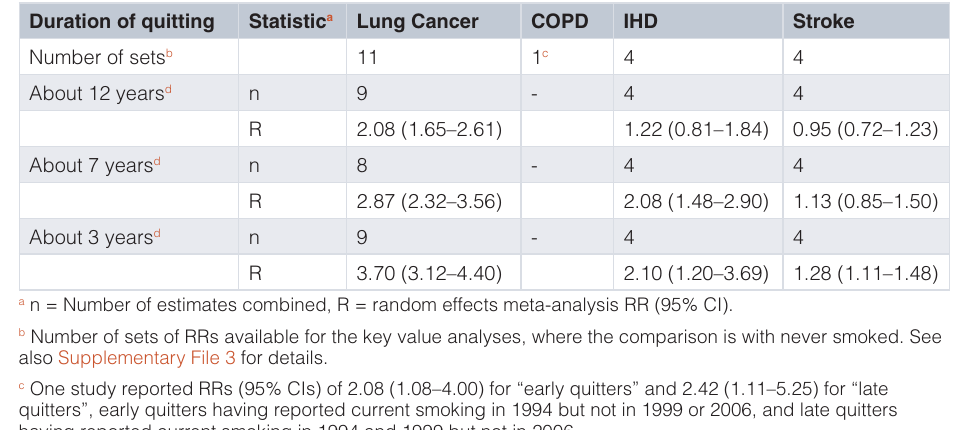
Table 6. Meta-analysis for duration of